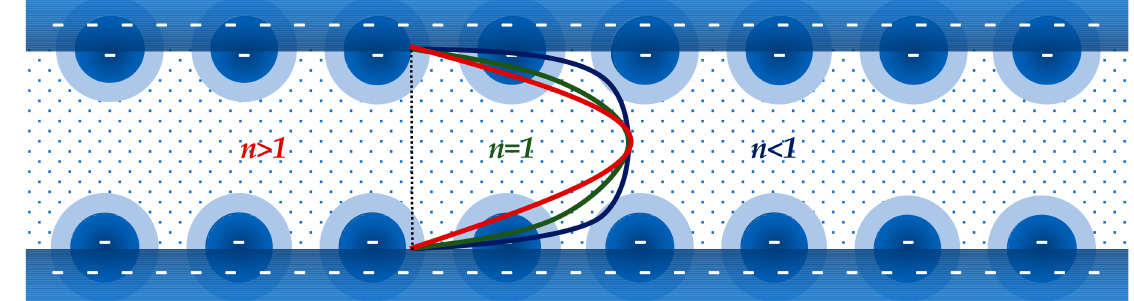
Figure 4. Velocity profiles of shear-thinning ( n < 1 ) , Newtonian ( n = 1 ) , and shear-thickening ( n > 1 )